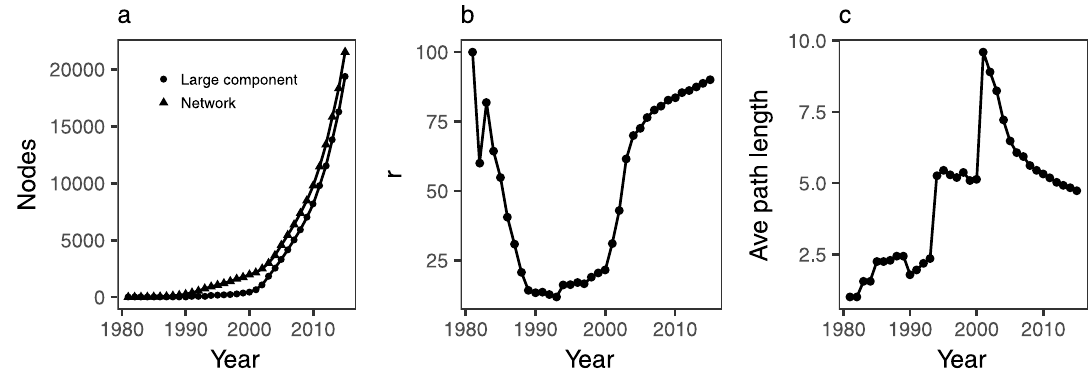
Fig 4. a) Number of nodes of the largest component and the ALD collaboration network; b) relative size of the largest component; c) averagepath length of the largest